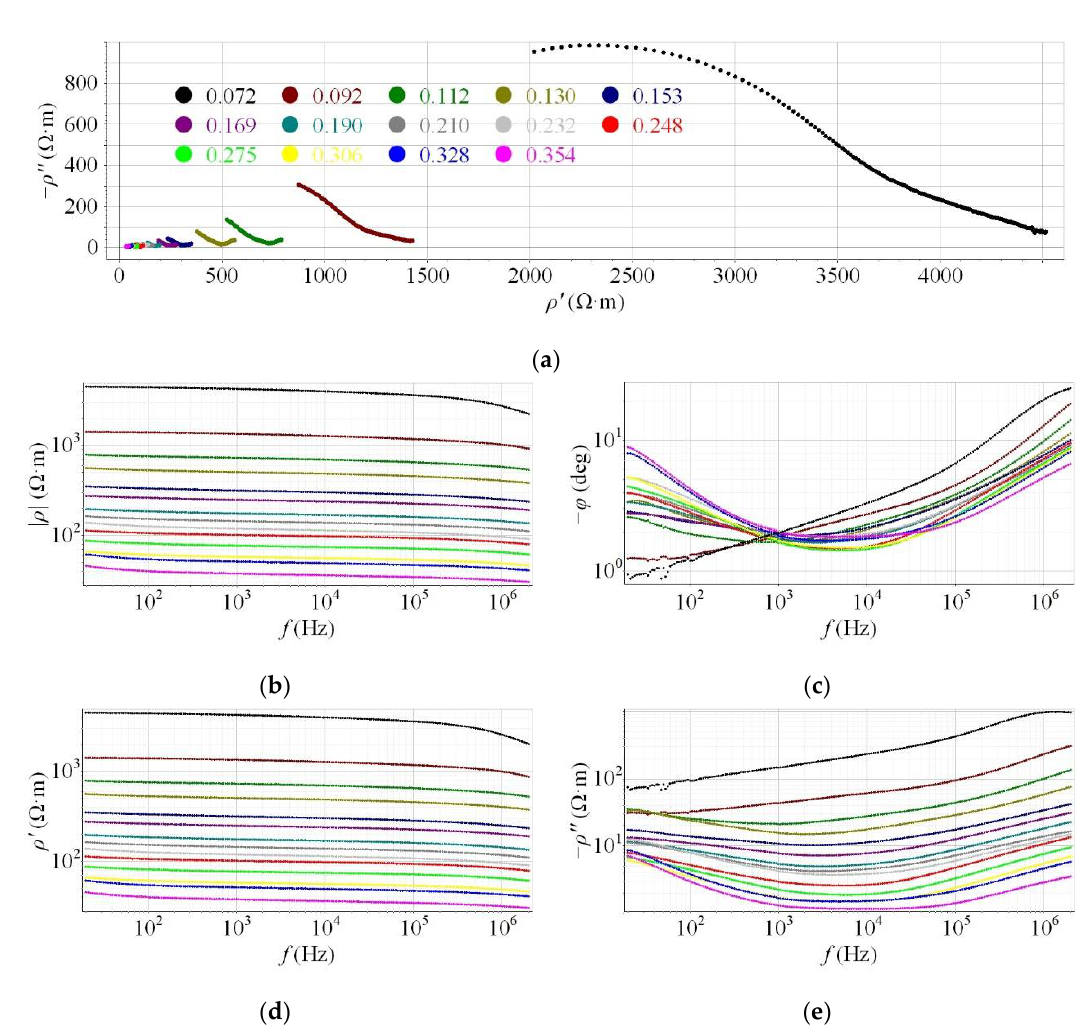
Figure A1. Impact of changes in volumetric water content on measured complex resistivity of substrate. ( a ) Nyquist plots; ( b ) magnitude spectra; ( c ) phase spectra; ( d ) in-phase conductivity spectra; ( e ) quadrature conductivity spectra. For the spectra marked by different colors, the variable volumetric water contents are provided in ( a ), while the related dry densities (Table 1) are considered to be nearly equal. The frequency range is from 20 Hz to 2 MHz.